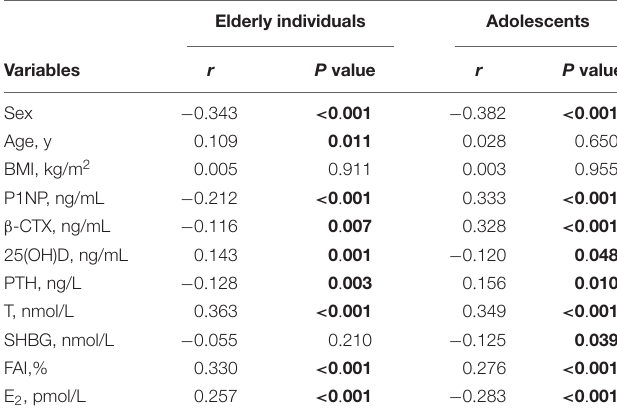
TABLE 2 | Correlation analyses of serum sclerostin and other parameters in elderly individuals and